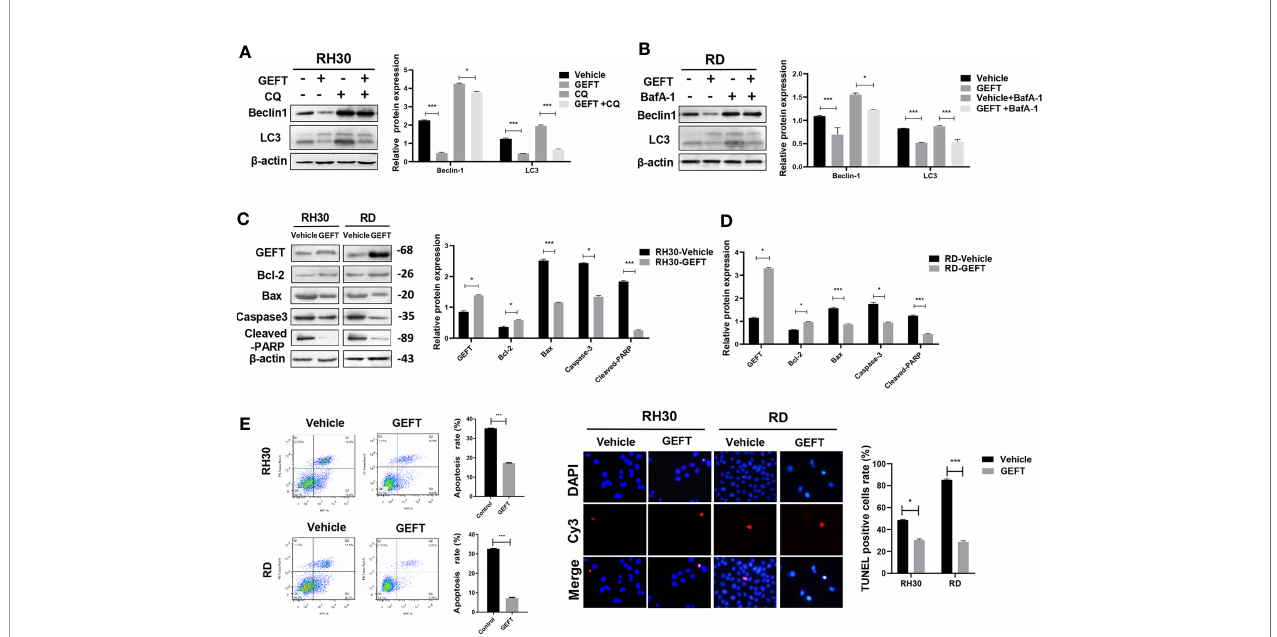
FIGURE 2 | GEFT affects the autophagy and apoptosis in RMS cells. (A) Western blotting was used to detect the expression of Beclin1 and LC3 protein in RH30 cells for control groups, control+CQ groups, transfected with GEFT, transfected with GEFT+CQ. (B) Western blotting was used to detect the expression levels of Beclin1 and LC3 protein in RD cells for control groups, control+BafA-1 groups, transfected with GEFT groups, transfected with GEFT+ BafA-1 groups. (C) Western blotting was used to detect the expression levels of GEFT, Bax, Bcl-2, Caspase-3, and Cleaved-PARP proteins in RH30 and RD cells transfected with the GEFT and control groups. (D) Apoptosis of RH30 and RD cells transfected with GEFT and control group was detected by fl ow cytometry. (E) Apoptosis of RH30 and RD cells transfected with the GEFT and control groups was detected by TUNEL. *** P < 0.001 and * P <